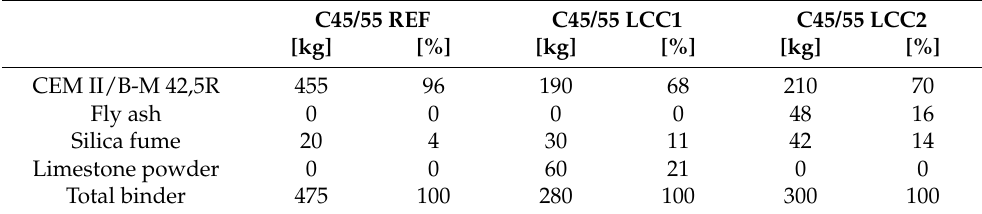
Table 3. Binder composition in kg and % per 1 m 3 of concrete.